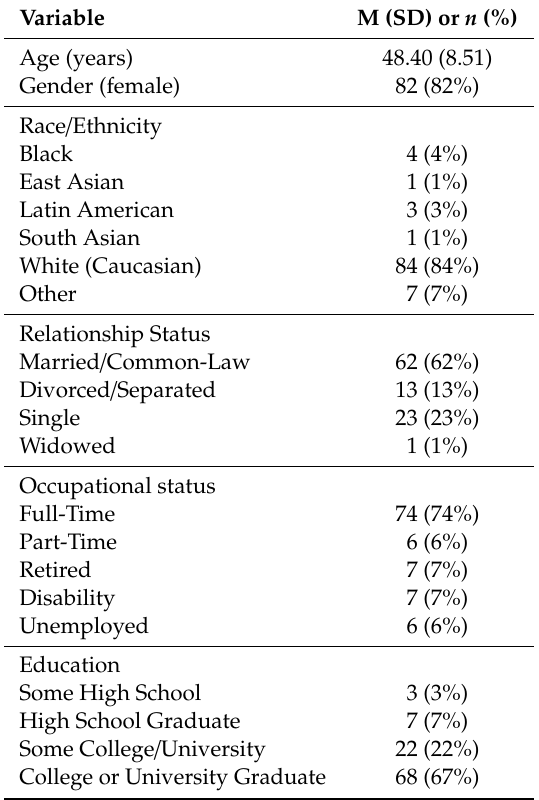
Table 1. Participant Characteristics ( n =